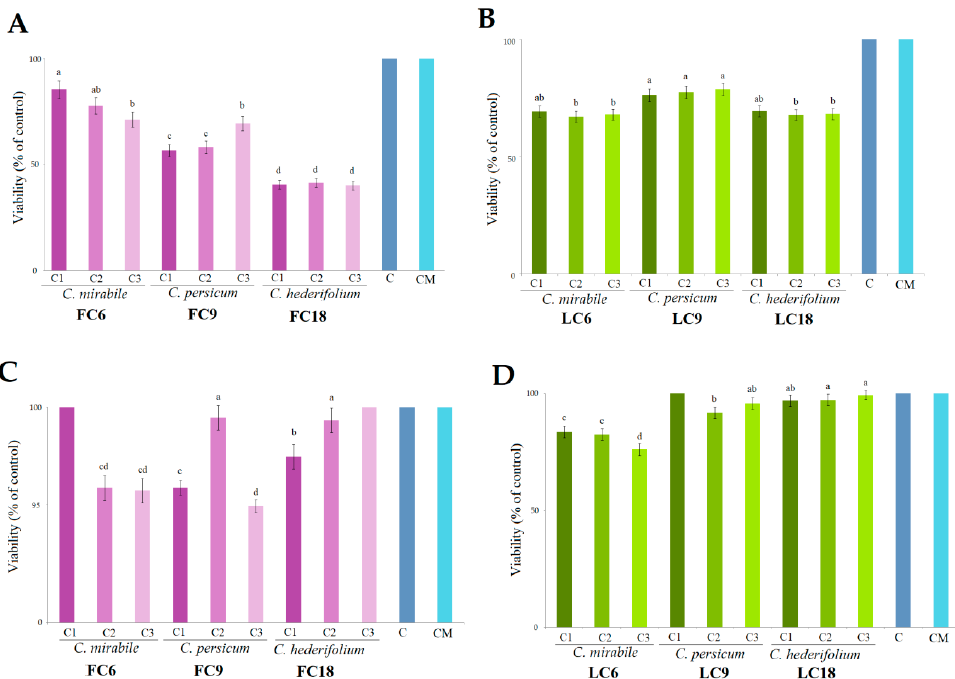
Figure 5. Inhibitory effects on MDA-MB-231 cell line of Cyclamen species ( A ) flowers and ( B ) leaves, and on BJ cell line of Cyclamen species ( C ) flowers and ( D ) leaves at three different concentrations (C1–C3) according to TPC (mg/g GAE) determined for each extracts. Different letters within a column indicate significant differences ( p < 0.05). C—untreated cells, CM—Methanol .